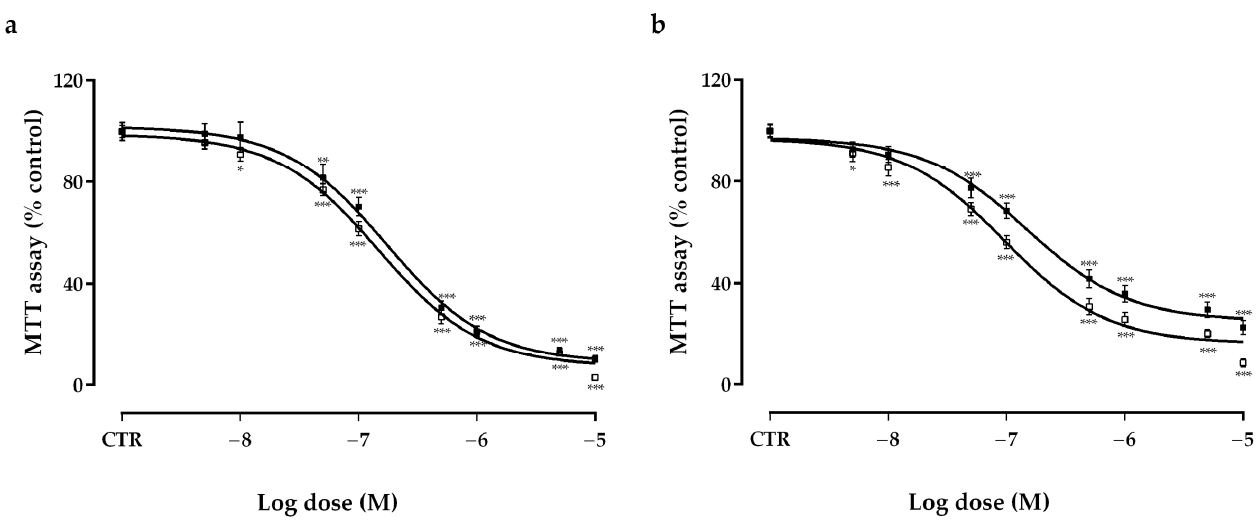
Figure 1. Effects of vandetanib (VAN) ( □ ) and cabozantinib (CAB) ( ■ ) on cell viability in TT ( a ) and MZ-CRC-1 ( b ) cell lines measured using an MTT assay. Cells were incubated for six days with vehicle (control), or with the drug at different concentrations, as described in the Material and Methods. Dose response curves were expressed as a nonlinear regression (curve fit) of log (concentration drug) versus the percentage of the control. Values represent the mean ± S.E.M. of at least three independent experiments in six replicates. Control (CTR) values have been set to 100%. * p < 0.05; ** p < 0.01; *** p < 0.001.